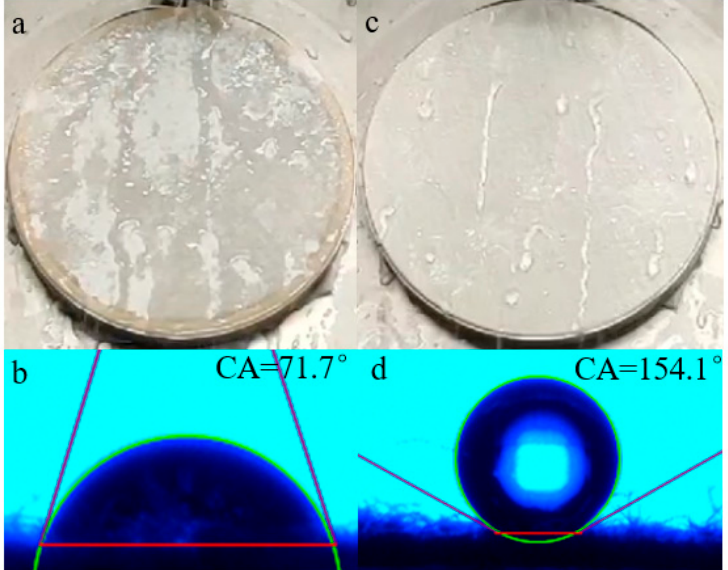
Figure 13. Spray property and static contact angles of untreated ( a , b ) and treated cotton fabric surface ( c , d ).